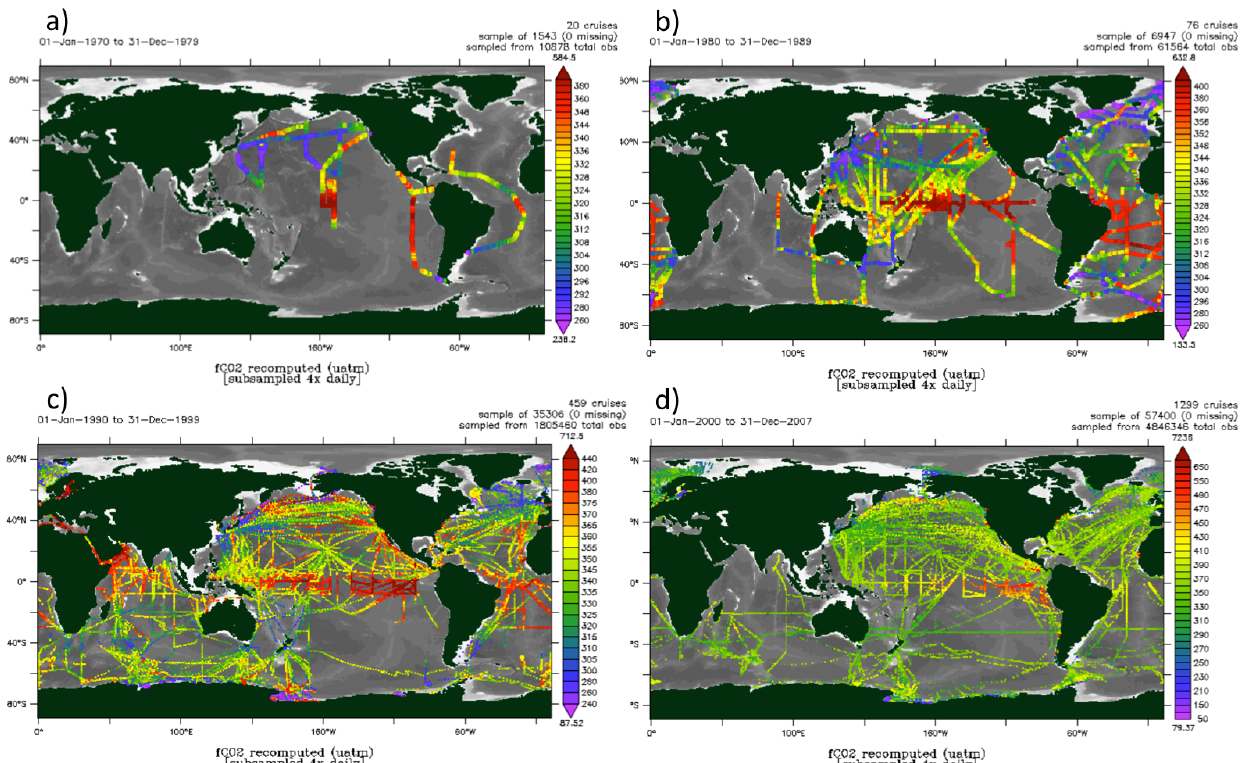
Figure 2. Distribution of data in SOCAT version 1.5 per decade: (a) 1970s, (b) 1980s, (c) 1990s and (d) 2000s.